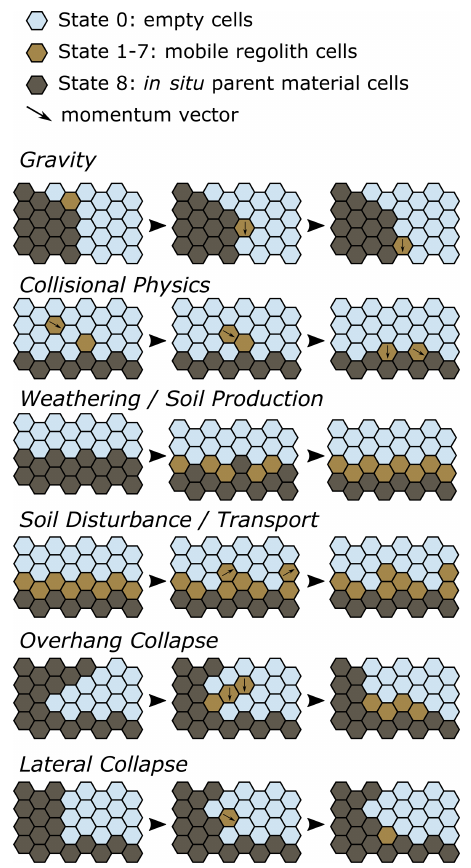
Figure 3. Illustration of a “cellular automata” type of model used to simulate colluvial wedge formation. The figure shows geomorphic processes included in the model for air, mobile regolith, and in situ parent material cells (following Tucker et al., 2016, 2018, 2020). Definitions for “mobile regolith” and “in situ parent material” are given in Sect.